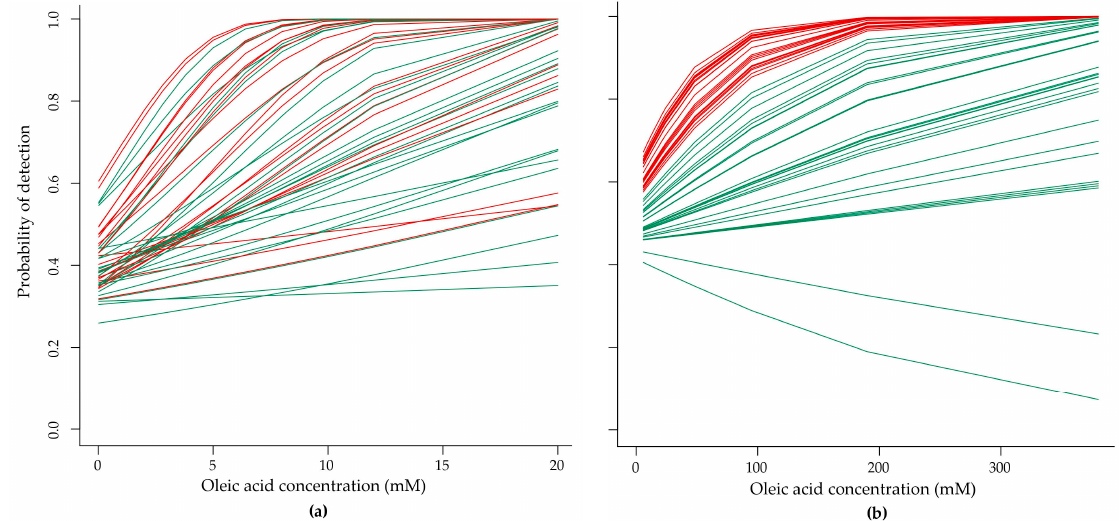
Figure 2. Comparison of ( a ) taste detection curves and ( b ) olfactory detection curves of oleic acid ( n = 50). Participants marked in red showed strong olfactory detection rate ( b ) and those same participants are shown in the taste model also in red ( a ). The fitted models of binomial regression for taste and olfaction show successful vs. failed individual trials across all three testing days (3-AFC) modelled with a link function.